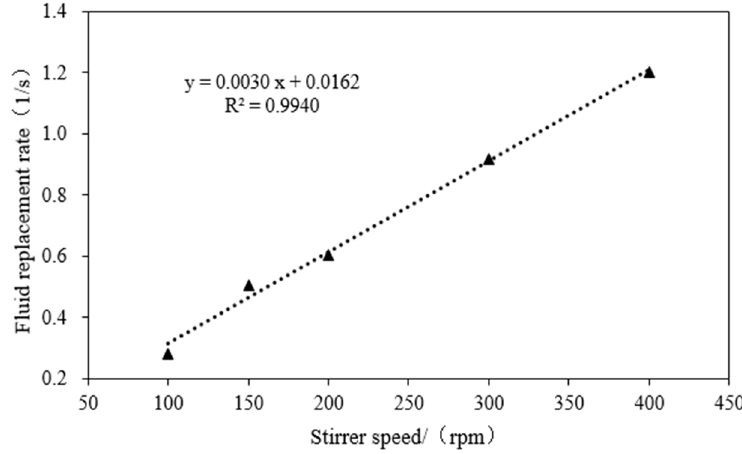
Figure 4. Correlation between the mixing time and stirrer speed.